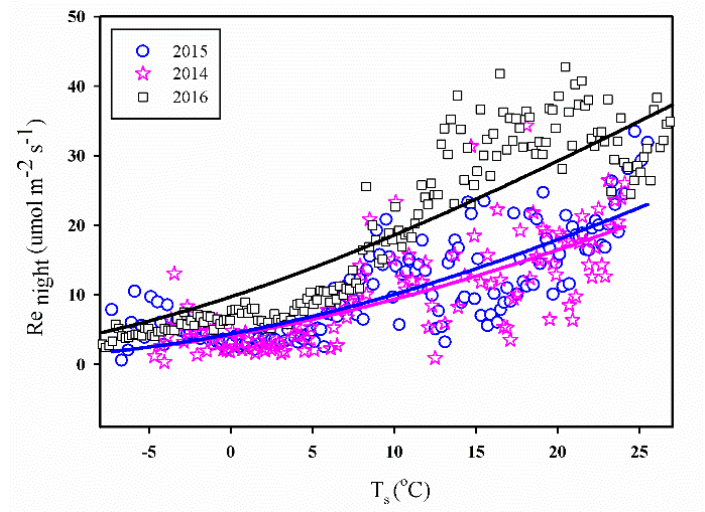
Figure 7. The relationship between raw half-hourly nighttime NEE (Re night ) and soil temperature ( T s ) data at the study site. Data of Re night used in curve fitting were averaged in 0.2 °C T s bins.